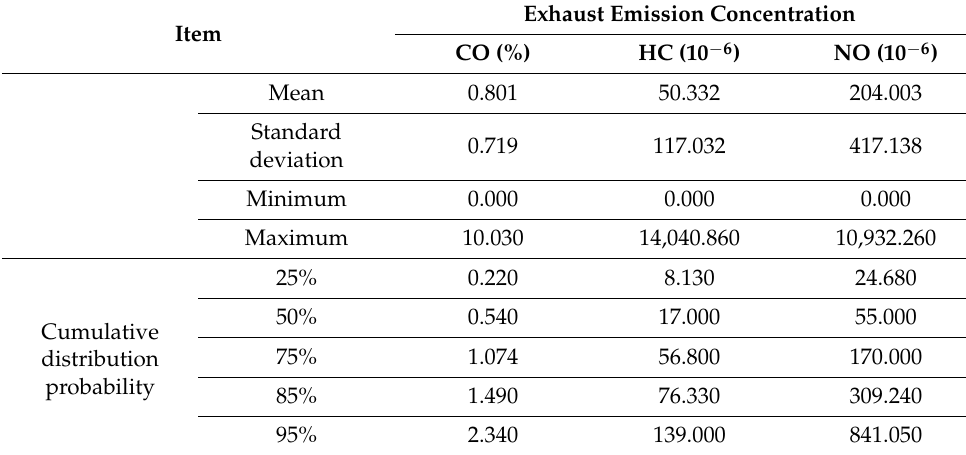
Table 1. Statistical analysis results of in-use gasoline vehicle